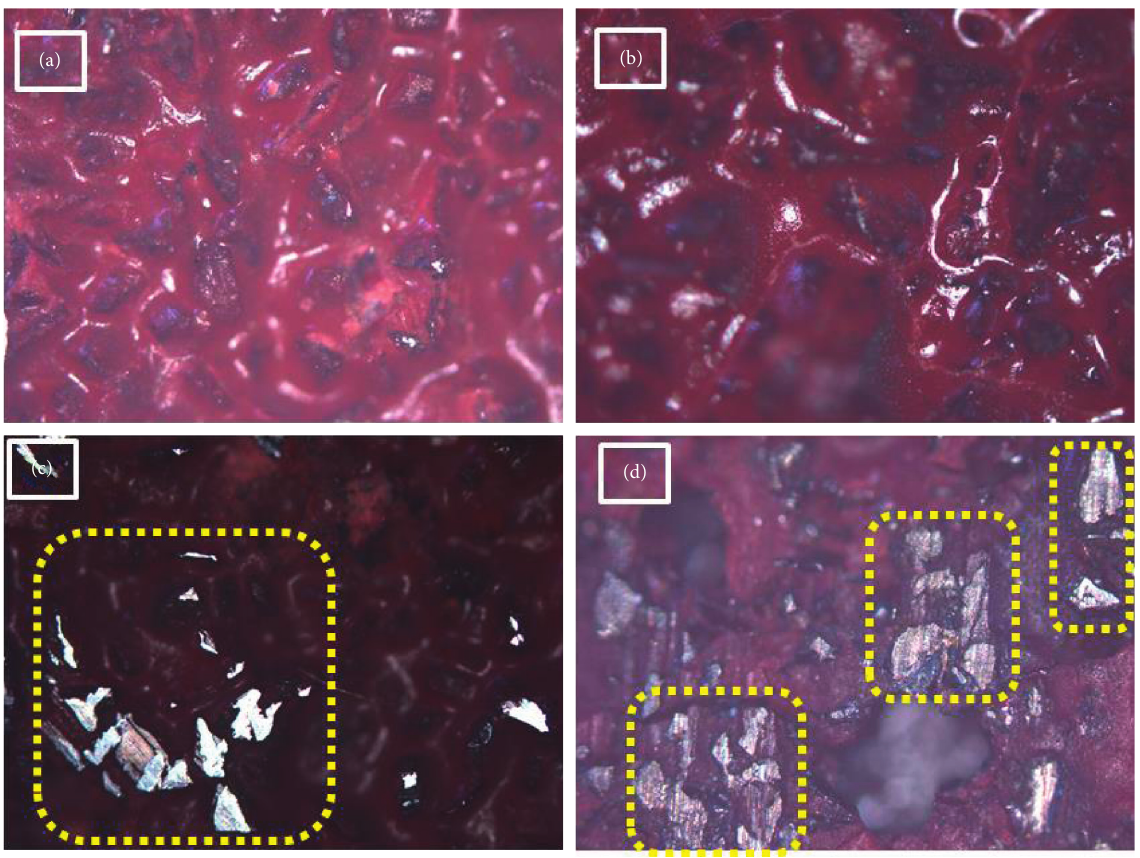
Figure 7: Optical images of produced coated abrasive discs (a) Standard disc (b) Recovered disc, (c) Performance evaluated recovered coated disc at 6th minute, and (d) Performance evaluated recovered coated disc at 10th